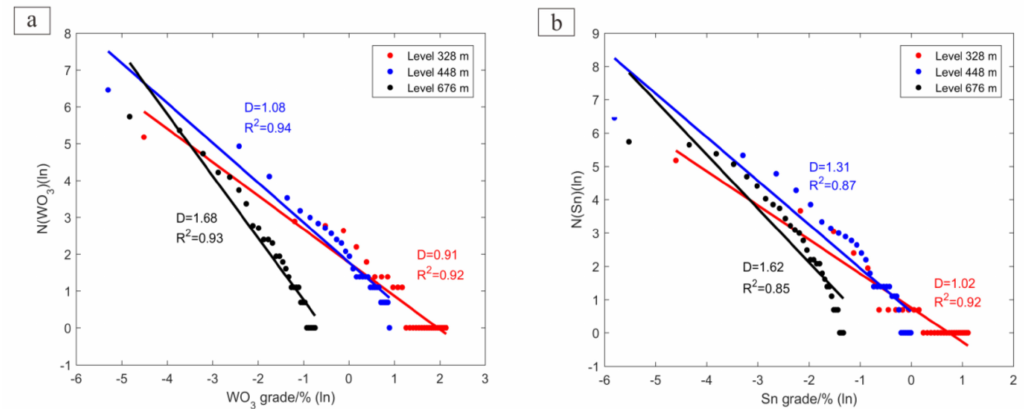
Figure 7. Log–log plots of the cumulative number of veins against WO 3 ( a ) and Sn ( b ) grade data at different levels. N ( WO 3 ) and N ( Sn ) are the numbers of veins whose WO 3 ( a ) and Sn ( b ) grades higher than given values. D is the fractal dimension and R 2 is the corresponding fitting degree. The slope of the fitted line is − D.